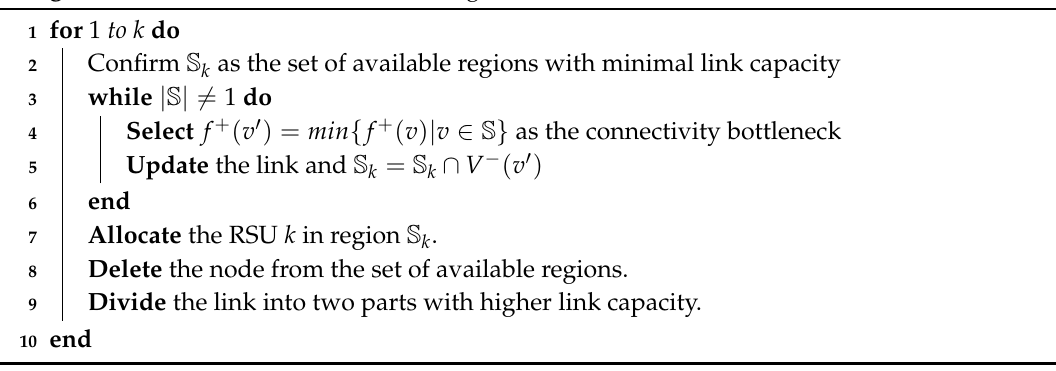
Algorithm 1: Bidirectional Allocation Algorithm